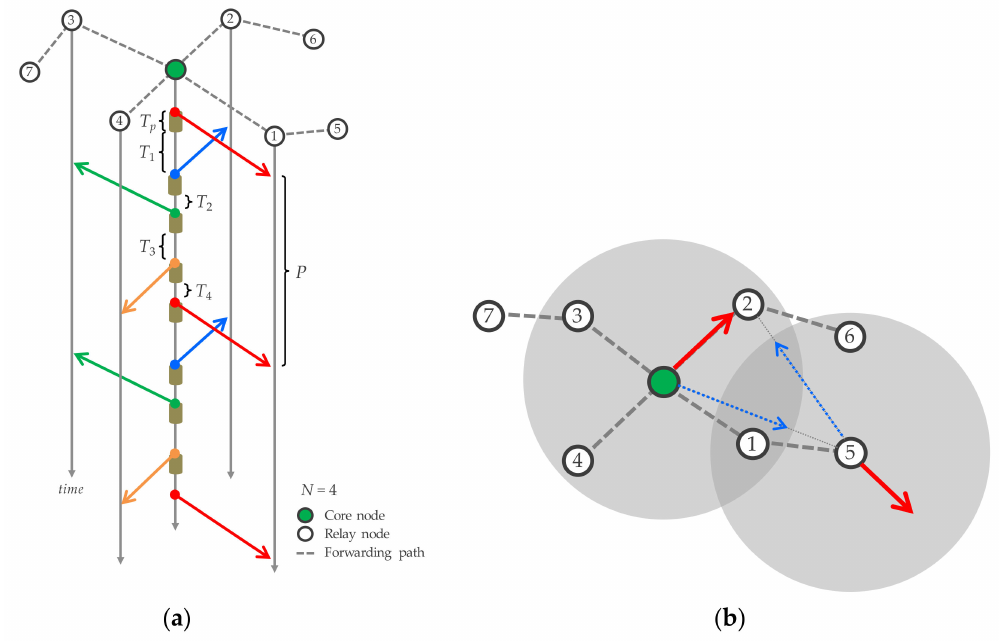
Figure 4. Round robin IPT (RR-IPT). ( a ) Transmission flow; ( b ) Frequency reuse on